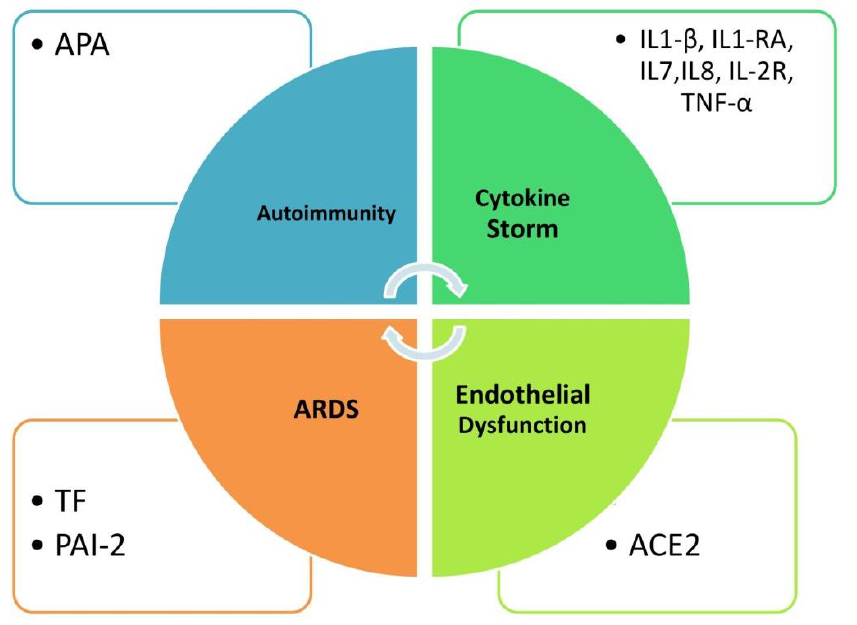
Figure 1. Contributory mechanisms of hypercoagulability in COVID 19 infection are autoimmunity and anti-phospholipid antibodies, cytokine storm-mediated thrombin overproduction, increased tissue factor and plasminogen activator inhibitor-2 levels due to ARDS-related tissue damage and ACE2 receptor-mediated endothelial dysfunction. APA anti-phospholipid antibodies, IL1RA interleukin 1 receptor agonist, IL-2R interleukin 2 receptor, ARDS acute respiratory distress syndrome, TNF tissue necrosis factor, ACE angiotensin converting enzyme, TF tissue factor, PAI-2 plasminogen activator inhibitor-2.